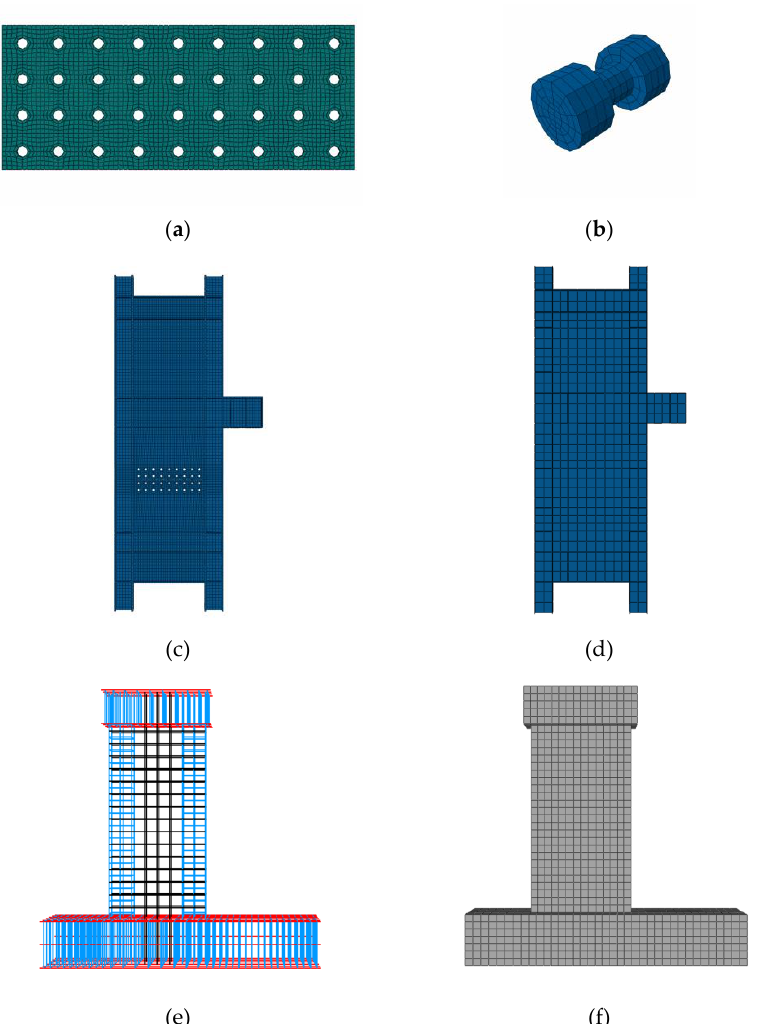
Figure 26. Meshing of FE model. ( a ) Faceplate in CS-2; ( b ) Bolt in CS-2; ( c ) SPSW in CS-2; ( d ) SPSW in CS-1, CS-3; ( e ) Reinforcement; ( f ) Concrete.